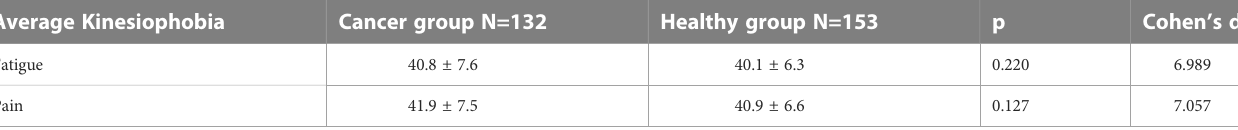
TABLE 3 Kinesiophobia rates of each group.